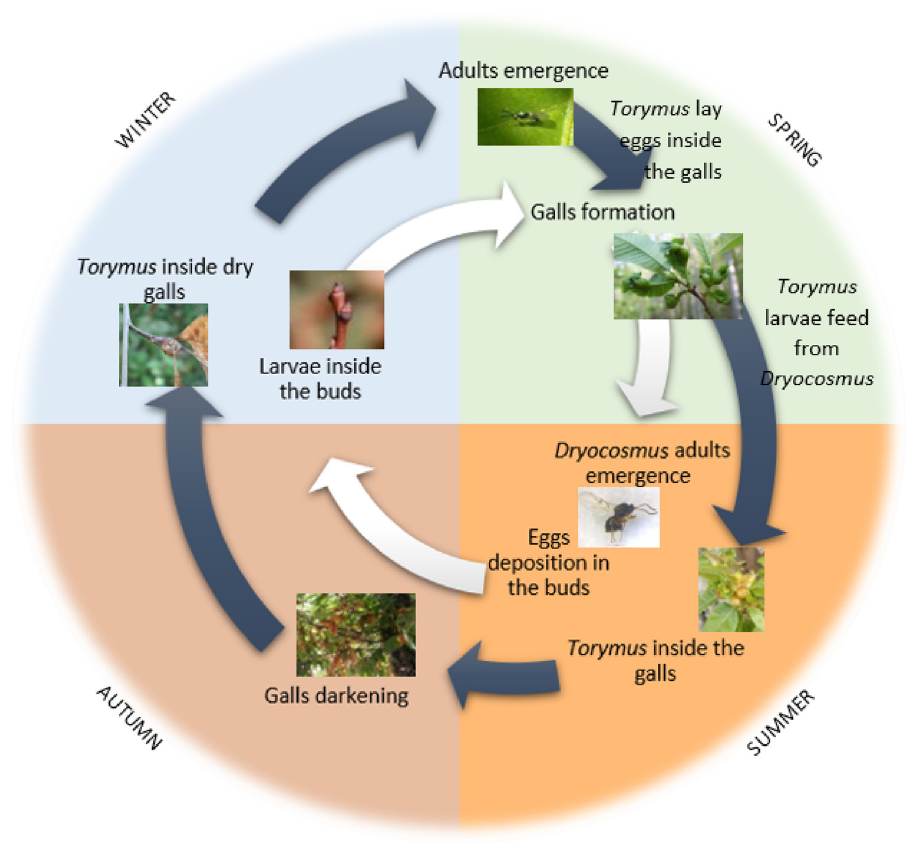
Fig 3. Biological cycle of Dryocosmus kuriphilus and Torymus sinensis